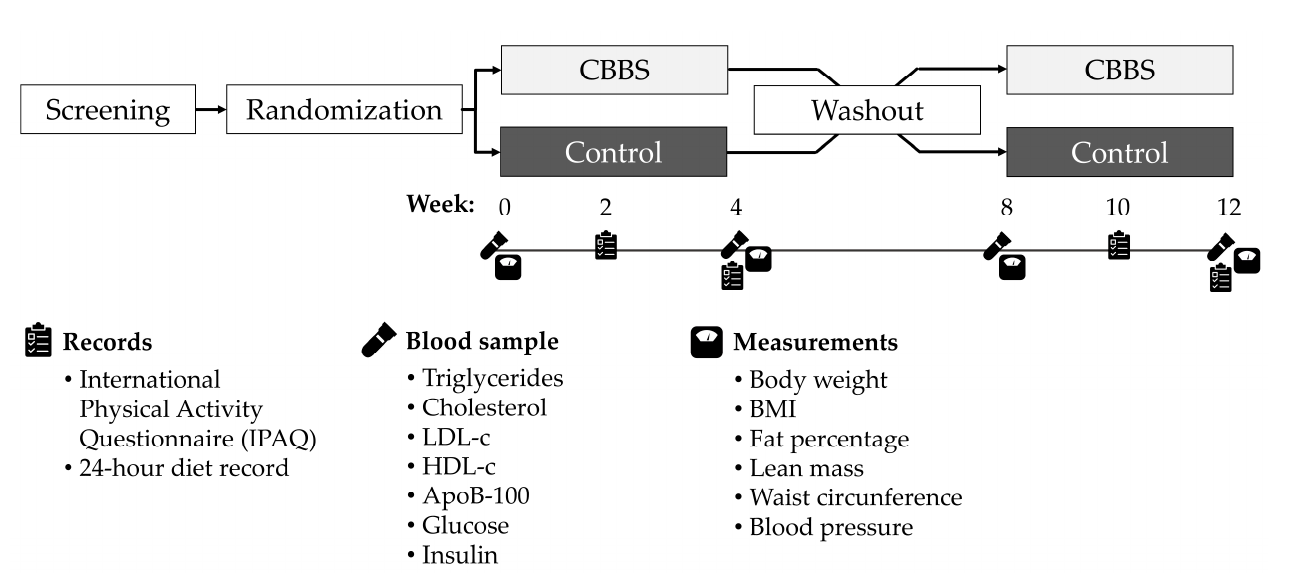
Figure 2. Study design diagram.